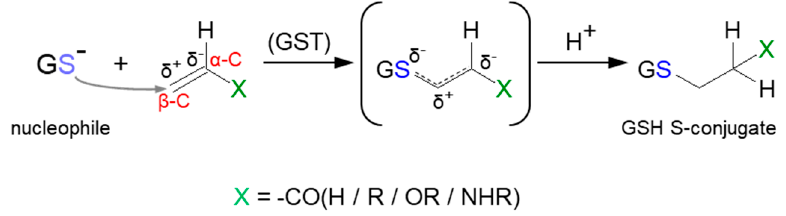
Figure 12. General scheme of Michael addition (or conjugate addition) to α , β -unsaturated compound with carbon − carbon double (C=C) bond.